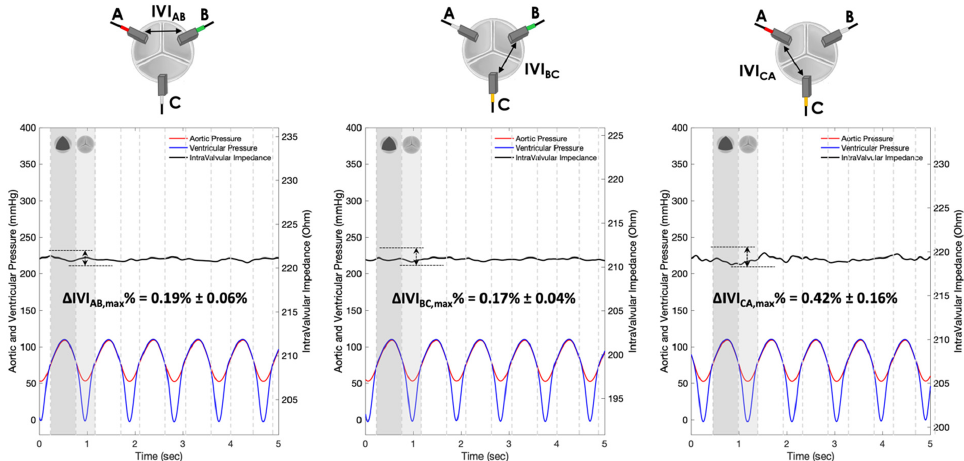
Figure 11. IVI measurements recorded for the three pairs of electrodes of Prototype 2 under normal leaflet dynamics: AB ( left ), BC ( center ) and CA ( right ).